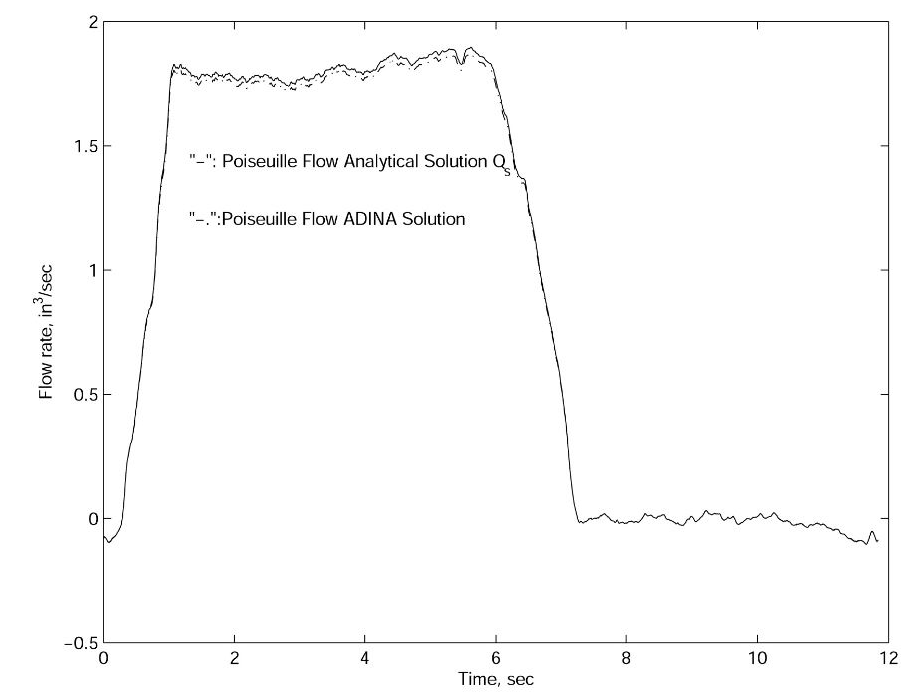
Figure 6. Quasistatic confirmation with CFD results for Poiseuille